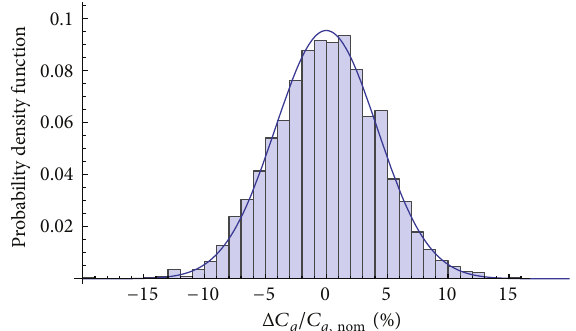
Figure 3: NMOS-based graphical comparison for the probability distribution of Δ𝐶 𝑔 : pdf Δ𝐶 tion from the circuit (histogram).